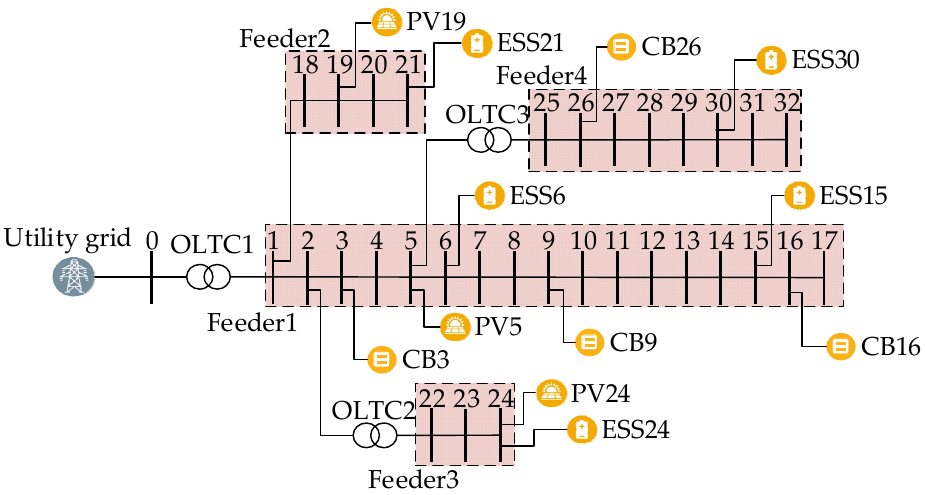
Figure 1. A modified 33-bus test system with multiple devices.